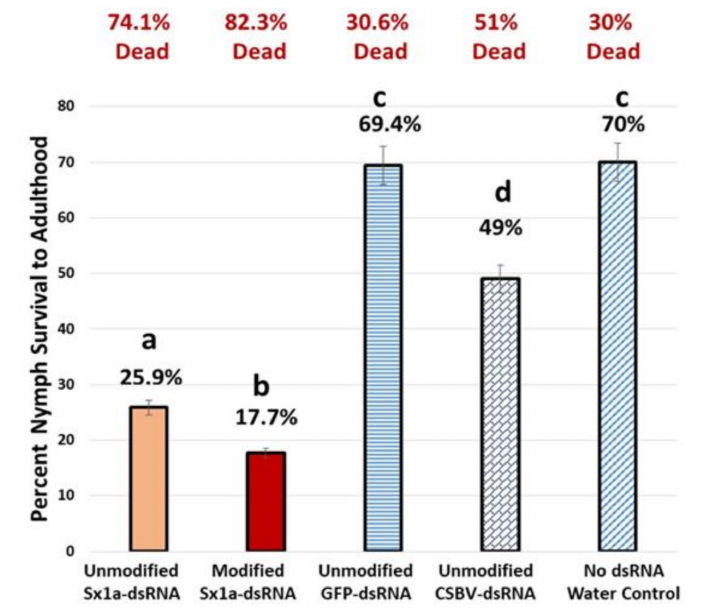
Figure 11. Evaluating unmodified nucleotides- vs. modified pyrimidines in dsRNA for improved RNAi activity in Bemisia tabaci . Significantly fewer whitefly nymphs completed development to adulthood on the tomato plants treated with modified (17.7%) and unmodified (25.9%) Syntaxin - dsRNA, compared to all controls (GFP-dsRNA 69.4%), CSBV-dsRNA (49%) and water control, No dsRNA (70%). Bars with ± SE of the mean, (n = 25), with six biological replicates, with three technical replicates. Experiment repeated three times. Bars with different letters are significantly different ( p <